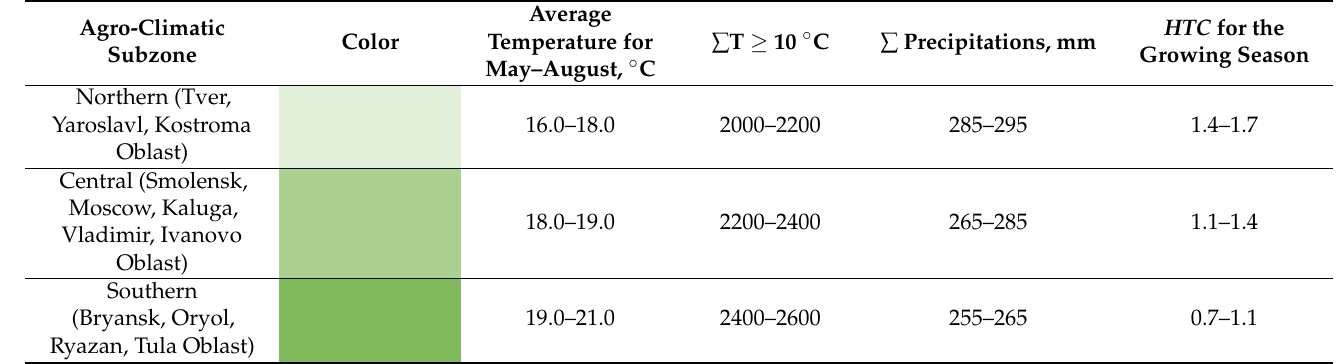
Table 1. Characteristics of the agro-climatic subzones of the Central region of Russian Non-Cherno- zem zone (1981–2020).